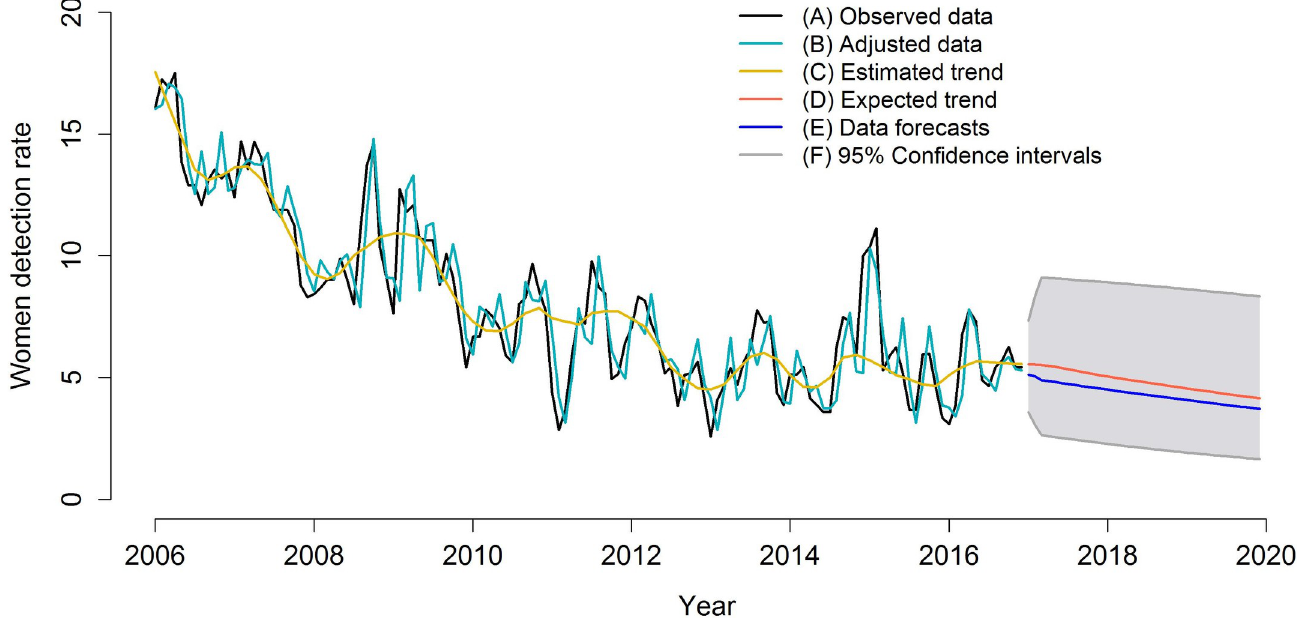
Fig 7. ARIMA model (0,1,3) adjusted for leprosy detection rates among women (2006–2016) and forecast of leprosy detection rates among women (2017– 2020), Imperatriz, MA, Brazil (2006–2016). (A) Observed data; (B) Adjusted data; (C) Estimated trend; (D) Expected trend; (E) Data forecasts; (F) 95% Confidence